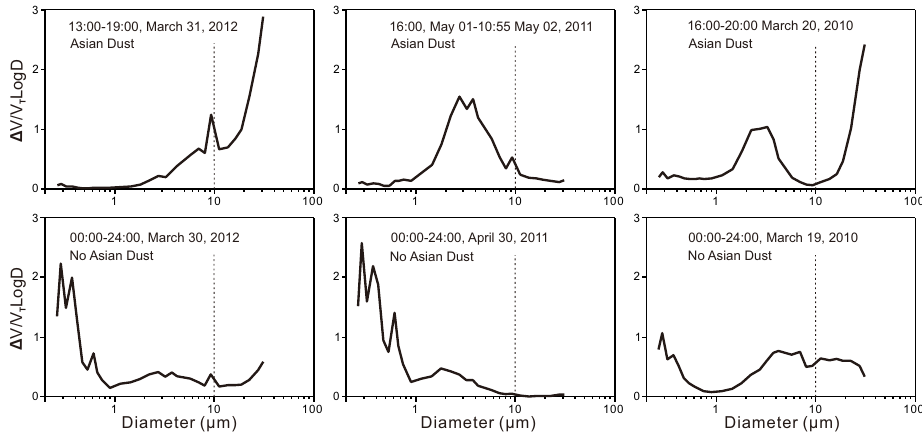
Fig. 6. Volume–size distributions of three Asian dusts measured with an optical particle counter at the Korea Meteorological Administration Asian dust monitoring station in Seoul, compared with those of non-Asian dust days. Dust event periods in Korea Standard